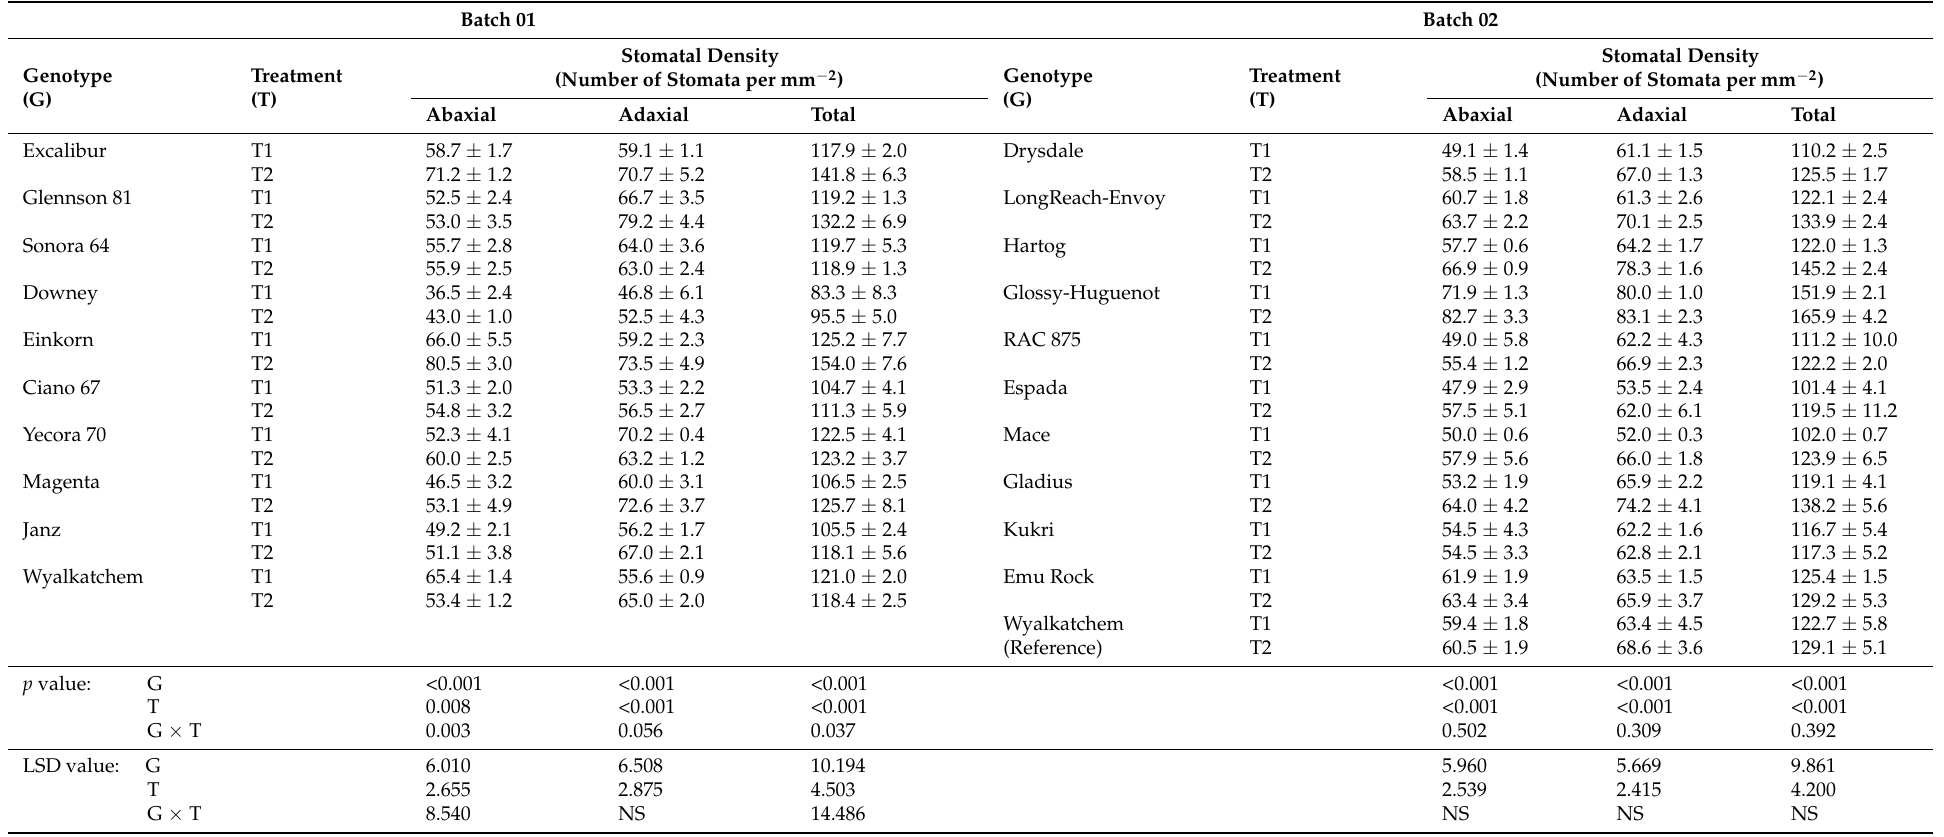
Table 1. Abaxial, adaxial, and total stomatal densities of 20 wheat genotypes in Batch 01 and 02 under ambient (T1) and high (T2) temperature regimes. Values presented are means ± SEM, n =